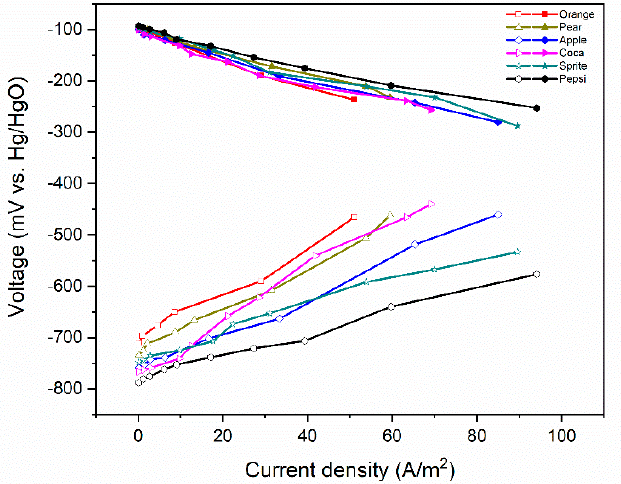
Figure 6. Cathode and anode polarization curves of the alkaline fuel cell filled with different sweet drinks.